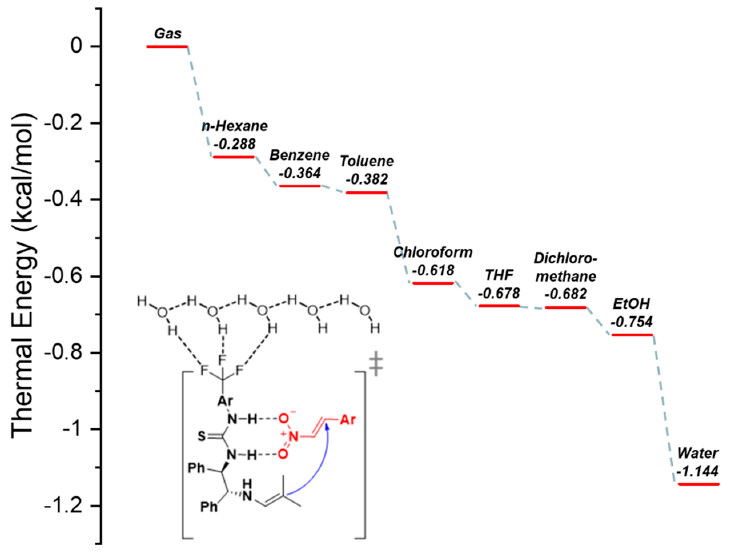
Figure 6. Proposed catalytic mechanism based on B3LYP/6-31G(d,p), on water solvent + H 2 O con- dition calculations and the thermal energy diagram of the ( R , R )-1,2-diphenylethylenediamine(DPE- N)-thiourea-catalyzed enantioselective Michael reaction. Based on the mirror image selectivity obtained through the Michael reaction using isobutyraldehyde and α , β -unsaturated nitroalkenes, it was deduced that the catalytic reaction proceeded via the mechanism displayed in Figure 7.